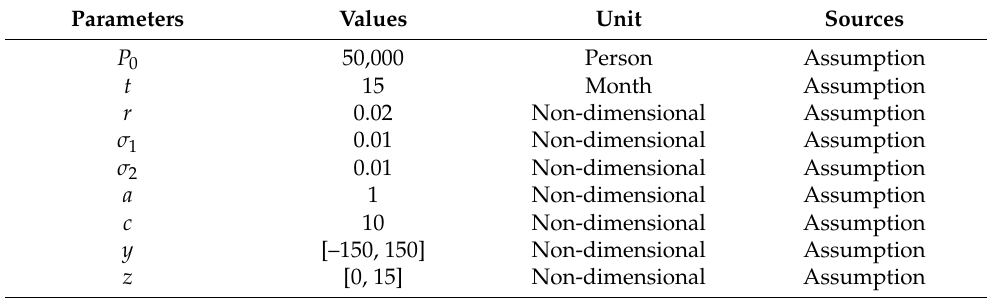
Table 1. Model parameter values.